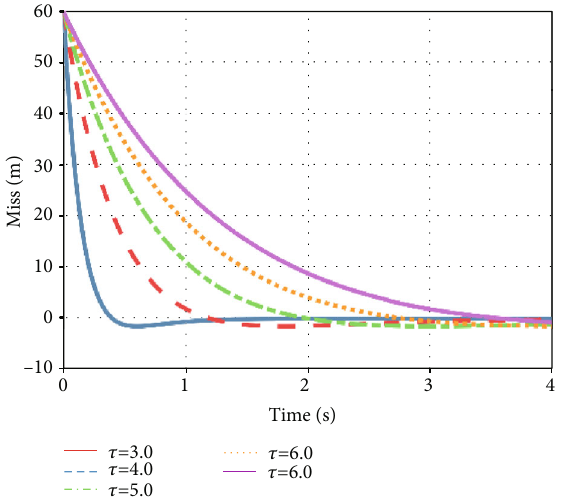
𝜏 =3.0 𝜏 =4.0 Figure 14: In fl uence of the time constant on the miss distance.